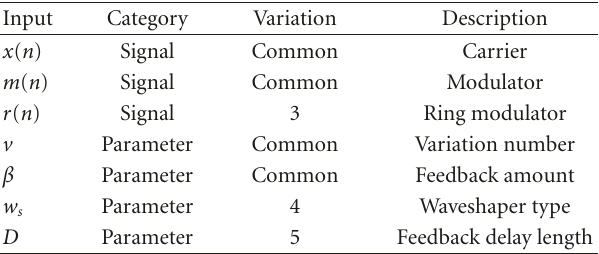
Table 1: FBAM input signals and synthesis